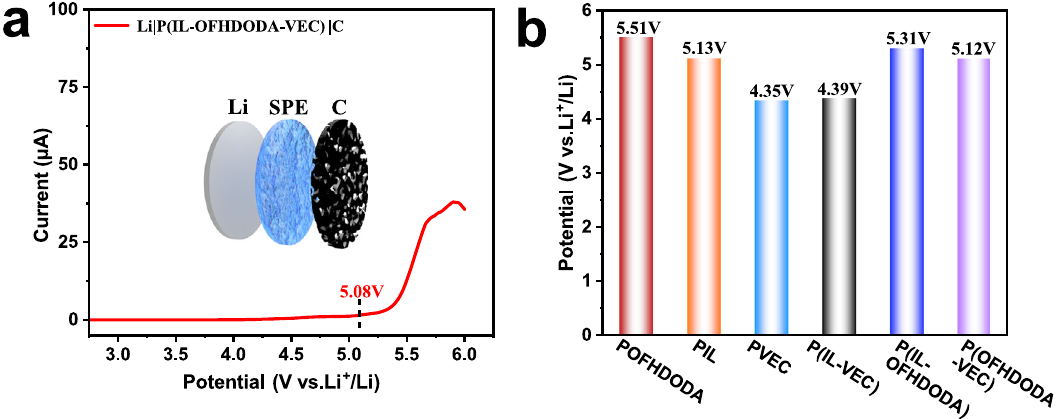
Fig. 3 | ESW of SPEs. a LSV curve of Li|P(IL-OFHDODA-VEC)| carbon. b ESW of PIL, POFHDODA, PVEC, P(IL-OFHDODA), P(IL-VEC), and